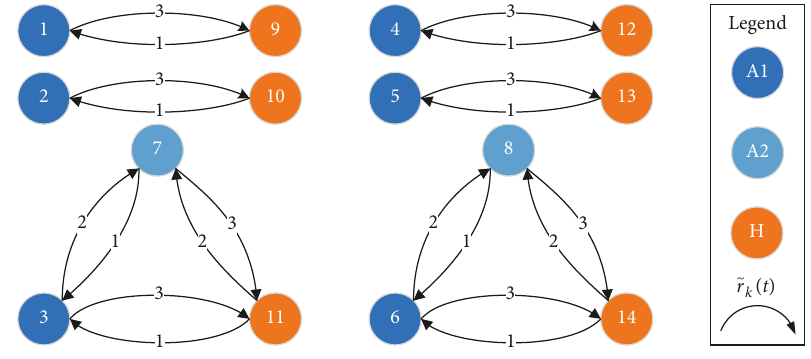
Figure 4: Mapping of k and k